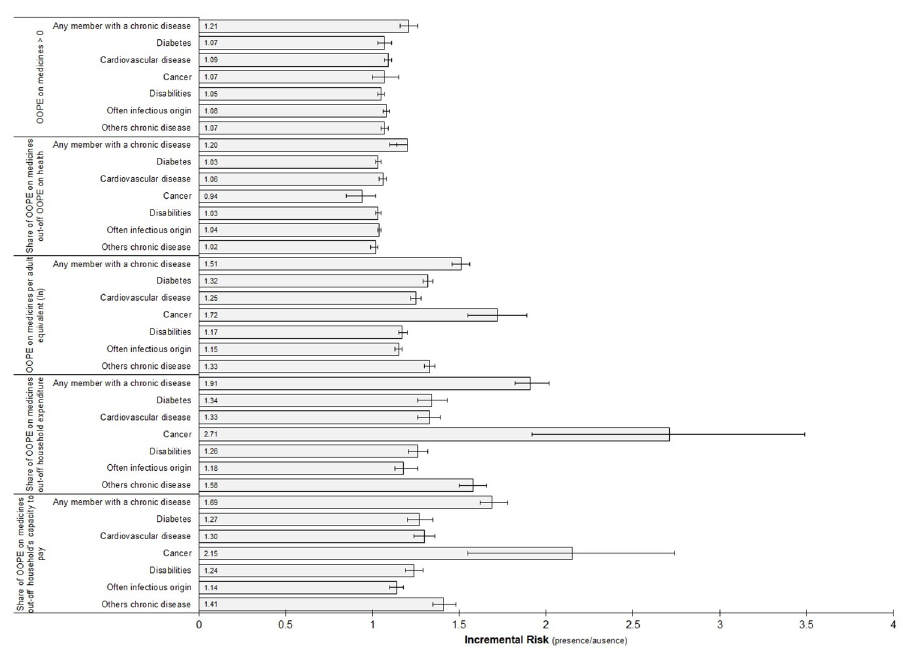
Fig 1. Adjusted incremental risk of OOPE on medicines according to household presence chronic disease. HIES, Bangladesh, 2016.